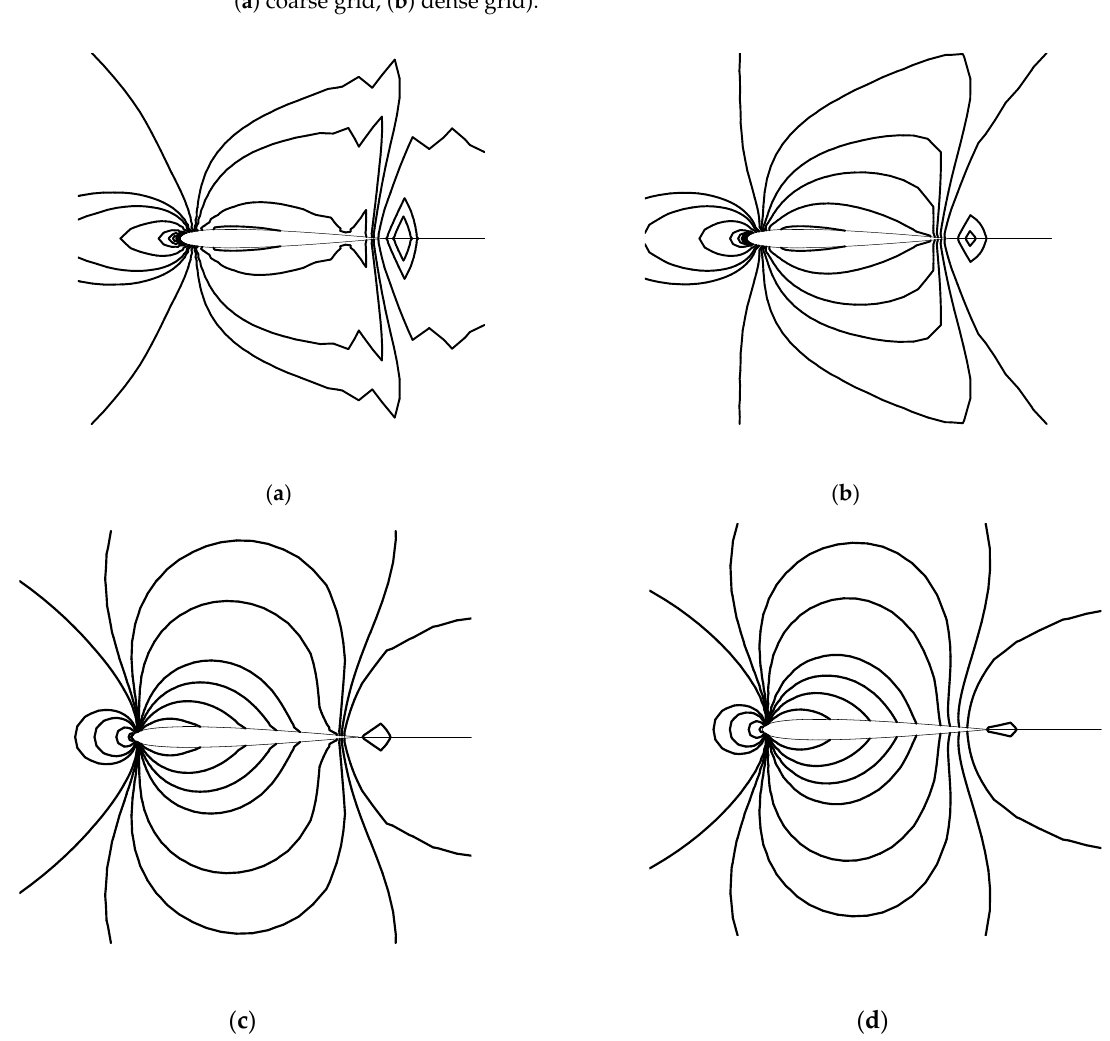
Figure 10. Error histories of inviscid flow over NACA0012 airfoil ( M ∞ = 0.1, first order reconstruction, ( a ) coarse grid, ( b ) dense grid).